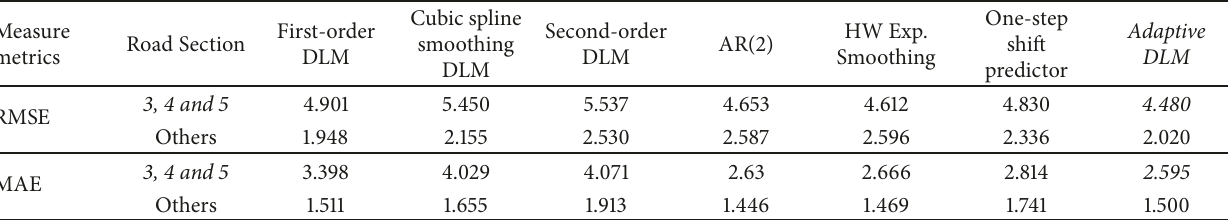
Figure 5: First-order DLM Kalman filter smoother fitted on average travel speed on link 4E. On the left: parameters ( 𝑉 0 , 𝑊 0 ) estimated by MLE; on the right: after optimization. Table 1: Average prediction accuracy of the adaptive DLM in accident